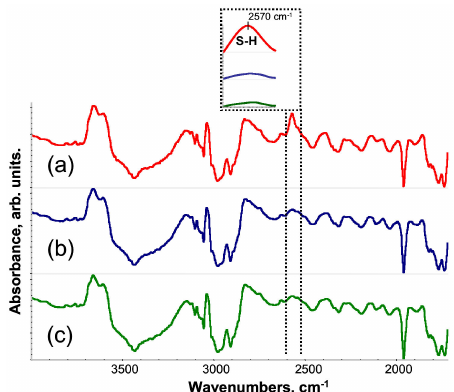
Figure 1. Fourier transform infrared (FTIR) spectra of PETMP-TTT reaction mixture for different UV curing time: ( a ) 0 s, ( b ) 30 s, and ( c ) 120 s. Inset: evolution of S–H